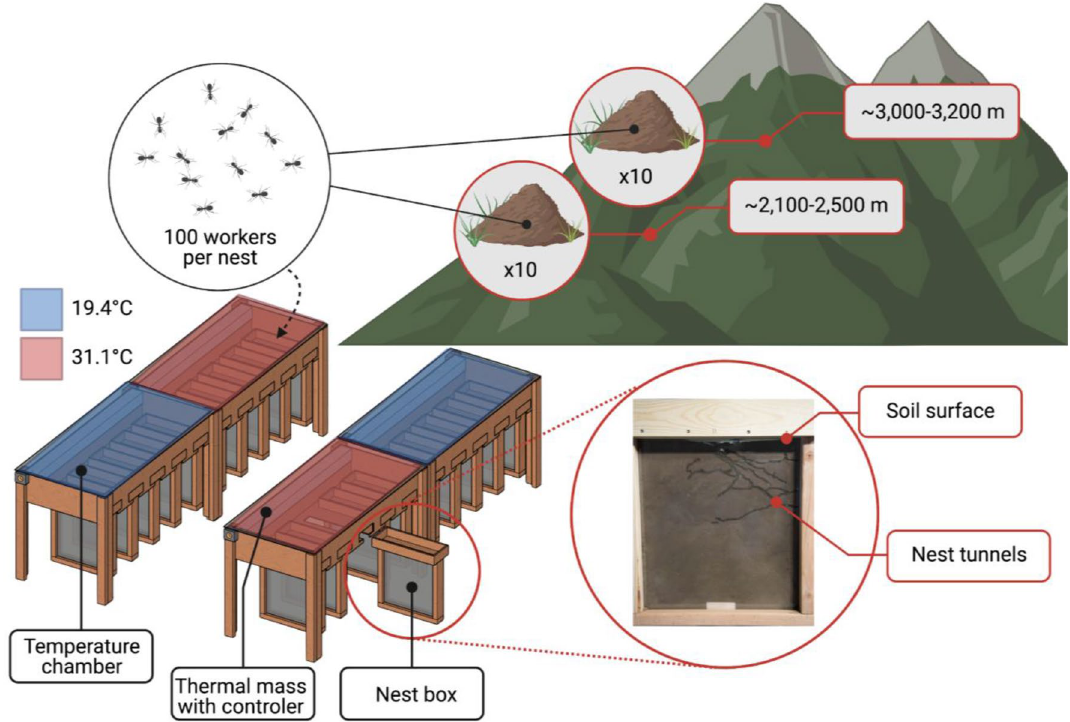
Figure 1. Overview of experimental design. We collected 100 workers from each of 20 colonies per trial (10 from higher elevation sites and 10 from lower elevation sites). We allowed colonies to excavate nests in boxes attached to temperature chambers at the soil surface level. There were four chambers, each containing five nest boxes and a mixture of low- and high-elevation colonies. We repeated this experiment three times during one summer to obtain a total sample of 60 colonies. Created with